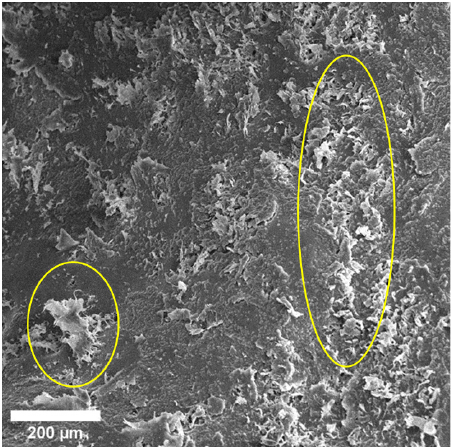
Figure 4. SEM image of bone area at proposed implant site. Spherical discharges are determined on surface of bone tissue. Similar results are found with a bone sample at 6 months (Figure 5). There are no visible traces of implant at the location of implant, and spherical discharges are present (Figure 6).